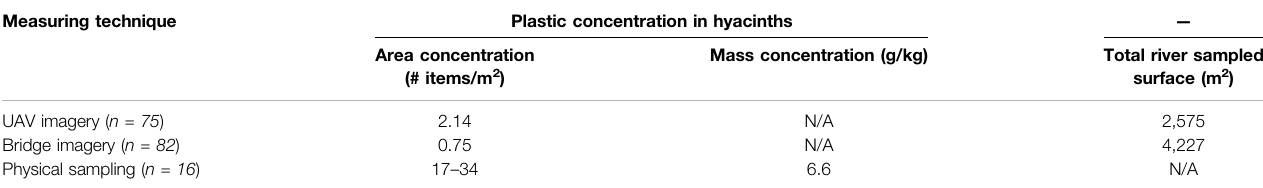
TABLE 1 | Plastic concentration in hyacinth patches. The concentrations are all mean values. The physical sampling area concentration is expressed as a range, as it considers the range of 15 – 30 kg of wet water biomass for 1 m 2 of hyacinth area (see Methods section). Measuring technique Plastic concentration in hyacinths — Mass concentration (g/kg) Total river sampled Area concentration surface (m 2 (# items/m 2 )